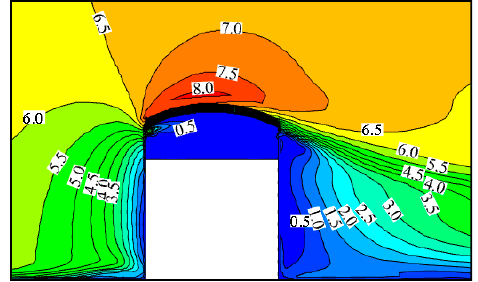
s − 1 . Processes 2020 , 8 , x FOR PEER REVIEW ·